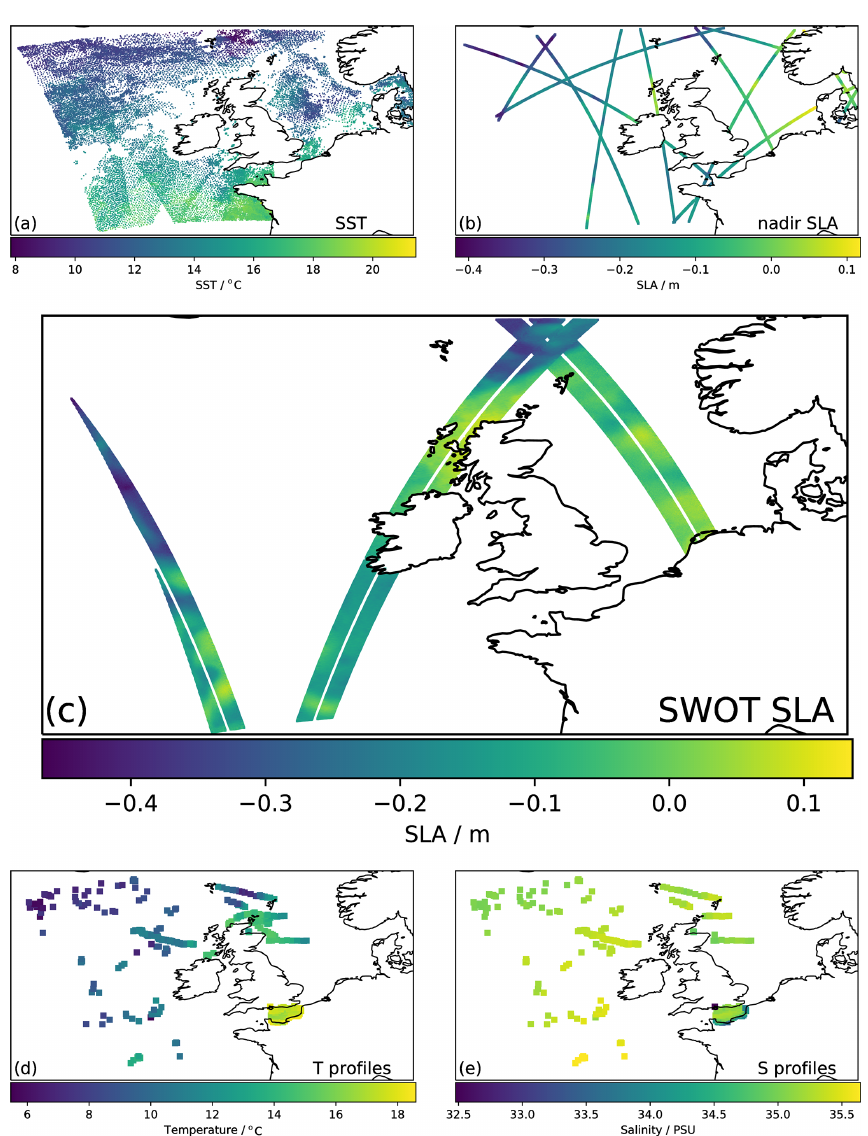
Figure 5. Example observation coverage for 1d (31 October 2017) for (a) SST, (b) nadir SLA and (c) SWOT SLA observations, and 1 month (October 2017) for (d) temperature and (e) salinity profile